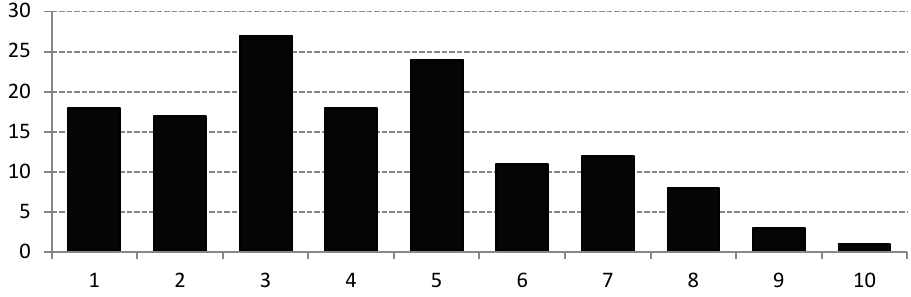
Figure 8: The perception of traffic contribution to air pollution in cities (scores 1 - 10) (1 - major negative impact, 10 - no negative